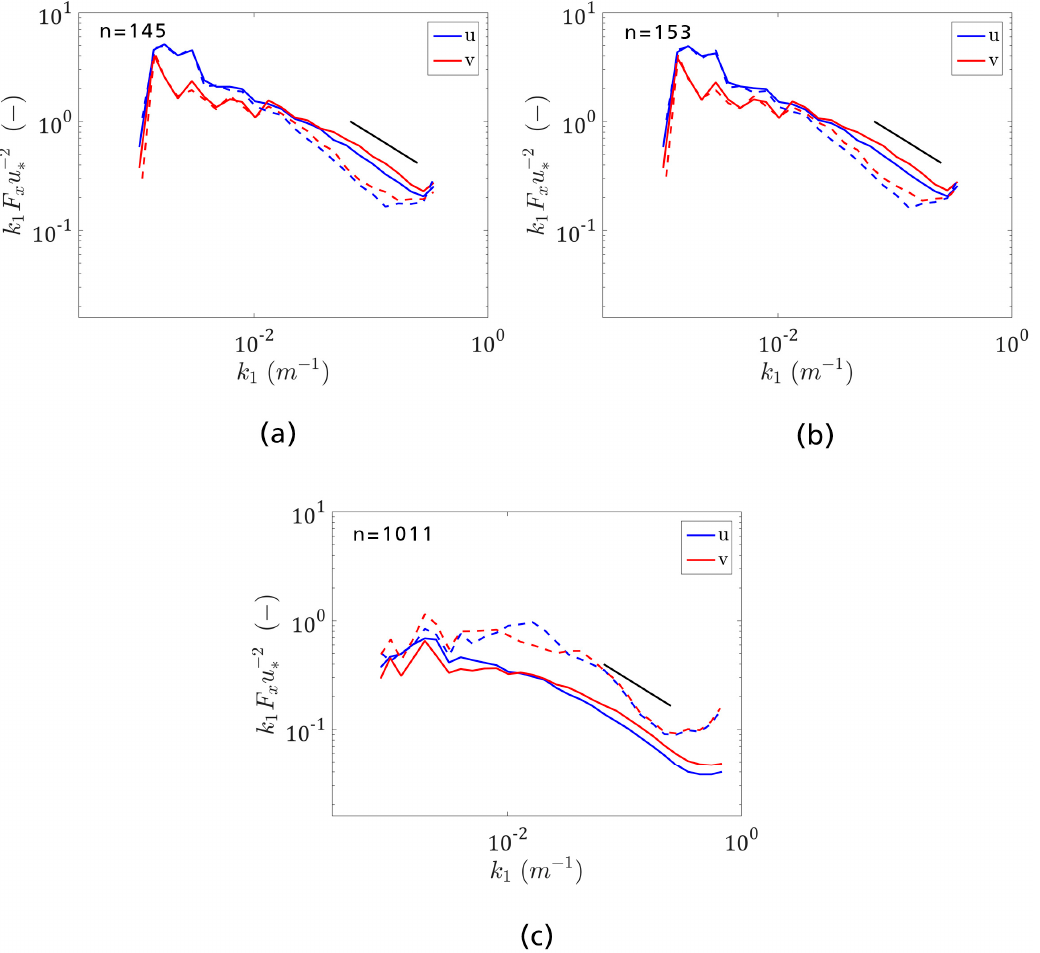
Figure 8. Normalised spectra of u and v . For ( a ) SW/SE/EE, ( b ) SW/SE and ( c ) Windcube v2 next to the mast; solid lines are the sonic spectra; dashed lines are the lidar spectra; sonic time series have been aggregated to 0.5 Hz (a and b) and 0.89 Hz before calculation of the spectra; only periods with u sonic > 4 m · s − 1 and u (cid:48) 2 sonic > 0.2 m 2 · s − 2 were used in the spectral averaging; u ∗ is the